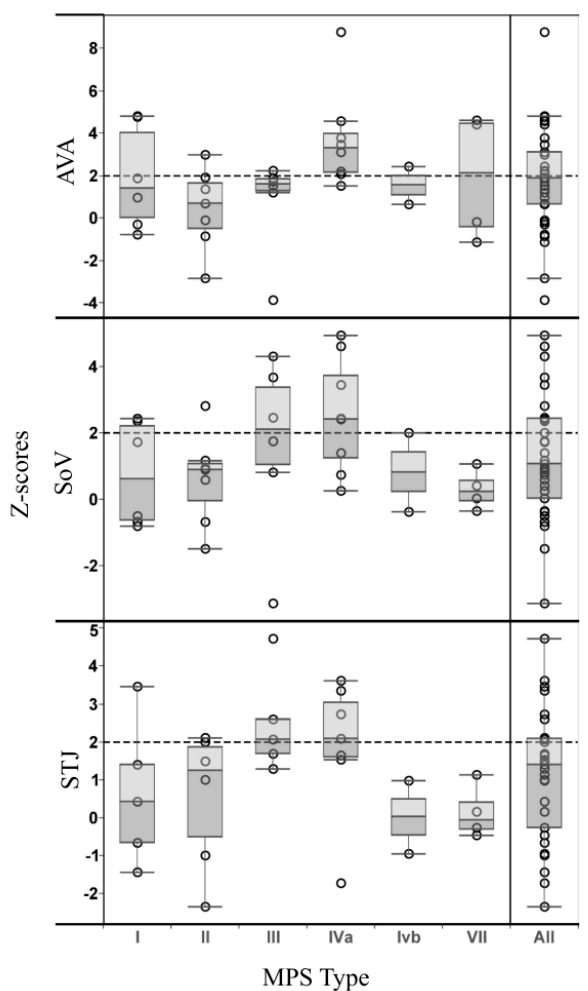
Figure 1. Z-scores of aortic root measurements for subtypes of mucopolysaccharidosis patients in a Tukey boxplot. The open circles represent the z-score of each individual patient at the AVA (aortic valve annulus), SoV (sinuses of Valsalva), and STJ (sinotubular junction). The 25–75th percent interquartile range is represented by the edges of the box. The circular points above the dotted line indicate aortic root measurements that exceed the 97th percentile of normal measurements.